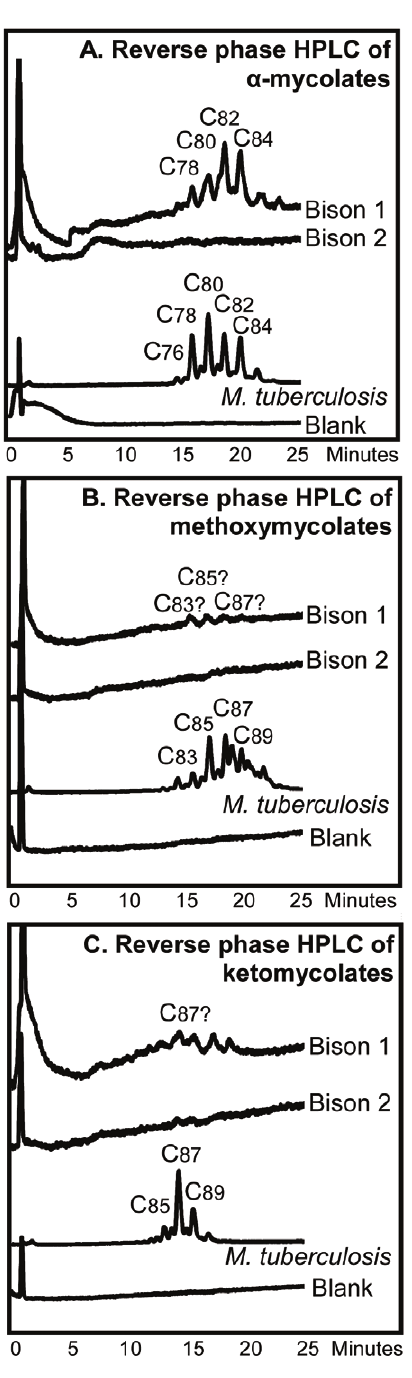
Figure 3. Reverse phase fluorescence HPLC of pyrenebutyric acid derivatives of pentafluorobenzyl esters of mycolic acid classes. The derivatives analysed were from Bison 1 and Bison 2 bones and standard M. tuberculosis . The analyzed fractions were collected from the normal phase separation (Figure 2B). A. a -Mycolates. B. Methoxymycolates. C.